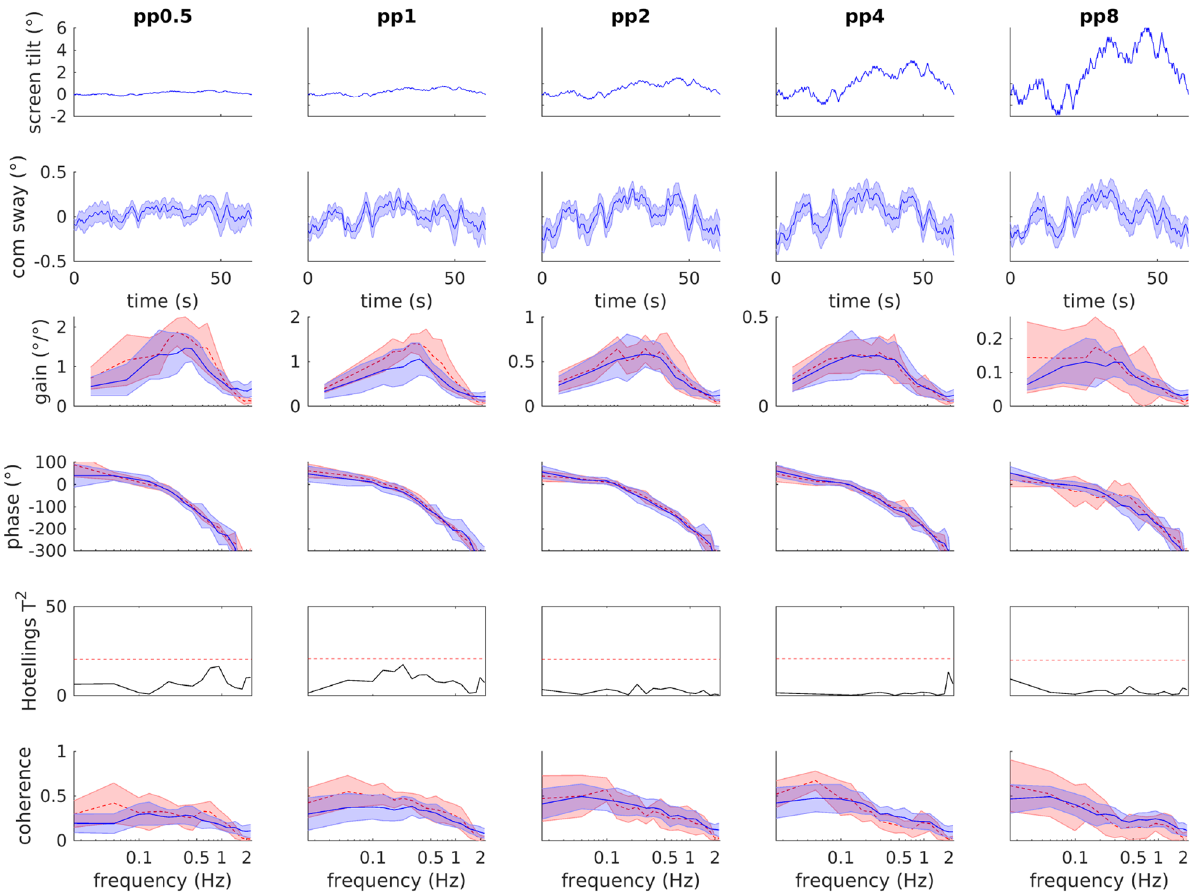
Figure 2. Long-PRTS sequences and sway responses of VR moving screen experiments (blue) and real-world sway responses 1 for comparison (red), each shown as mean and 95% confidence interval (shaded area). The stimulus sequence (top row) was applied at five peak-to-peak amplitudes. Each pp condition contains averages across eight repetitions of the sequence and 14 subjects. Row two shows the averaged center of mass (com) sway, rows 3 and 4 the frequency response functions (FRFs) displayed as gain and phase across frequency. Row five shows the statistical comparison of VR and real-world FRFs, where the red dashed line indicates the α = 0.05 cutoff. Bottom row shows coherence indicating the ratio between random-sway and sway evoked by the stimulus. Smaller values indicate a larger random sway